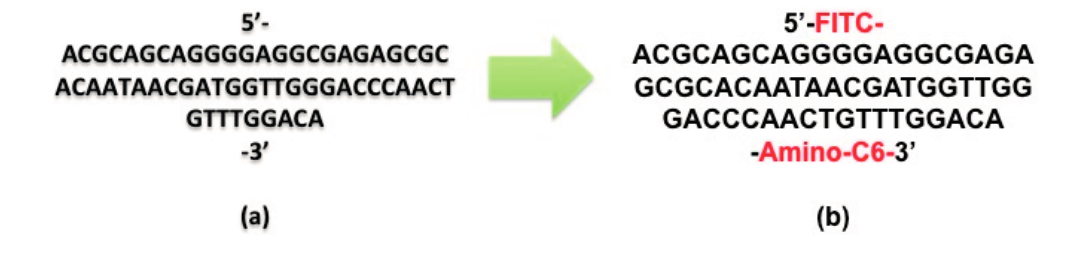
Figure 2. Synthesised DNA aptamer ( a ) prior to and ( b ) after